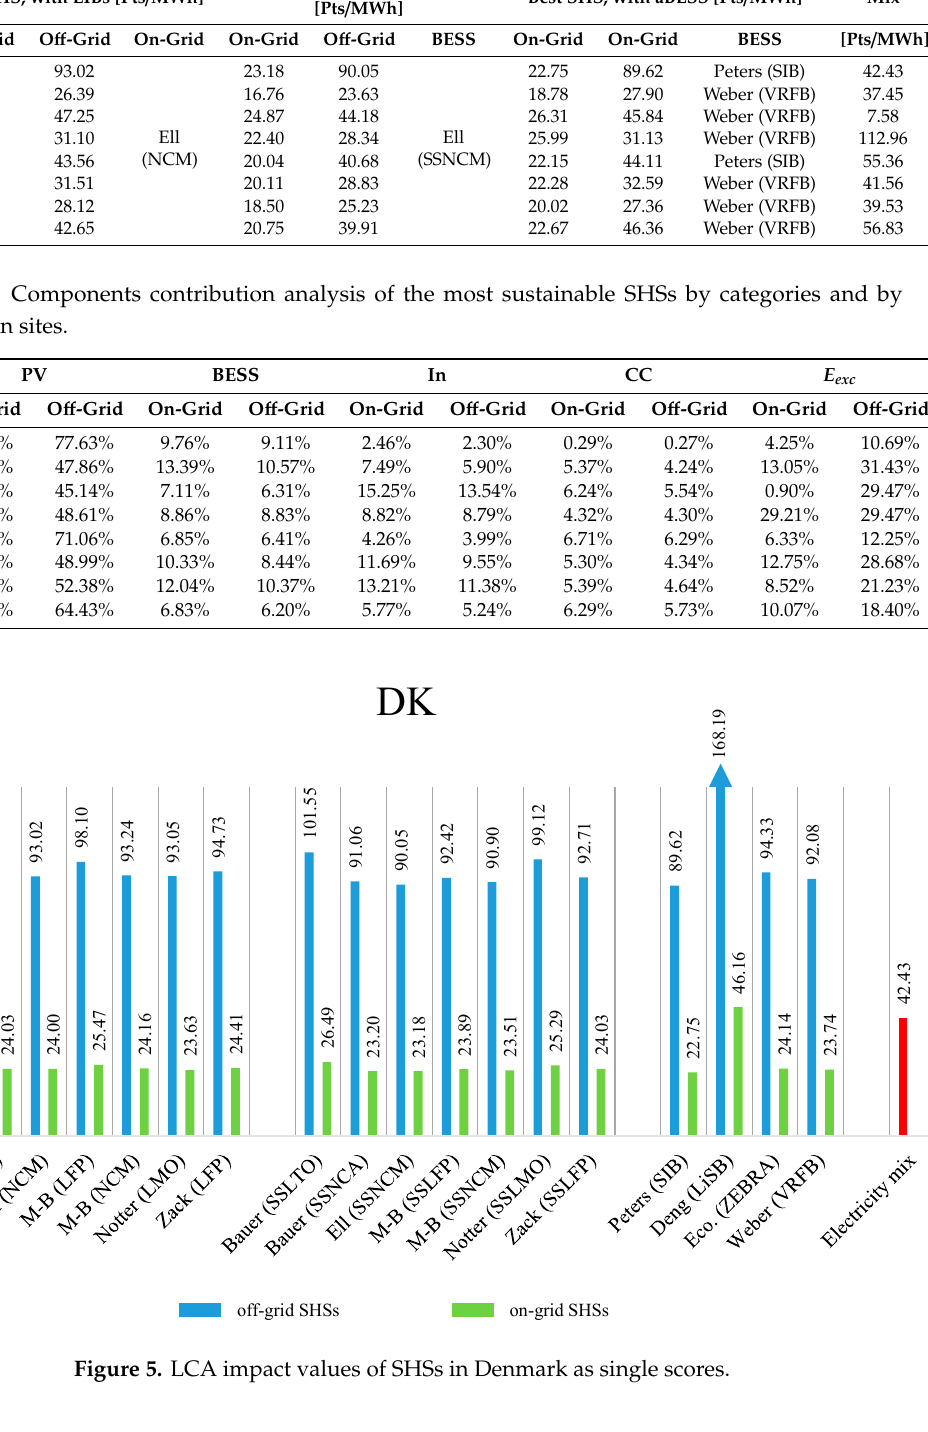
Table 10. LCIA results of the most sustainable batteries by categories and by installation sites. Best SHS, with SSLIBs Best SHS, with aBESS [Pts / MWh] Mix Best SHS, with LIBs [Pts / MWh] [Pts / MWh] On-Grid O ff -Grid On-Grid On-Grid O ff -Grid BESS On-Grid On-Grid BESS [Pts / MWh]